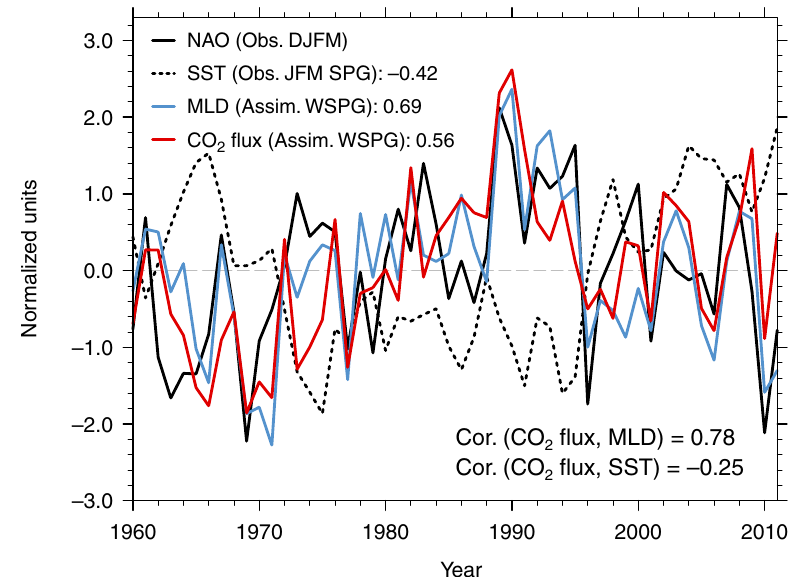
Figure 2 | Normalized time series of CO 2 flux and related physical variables. The observed (Obs.) DJFM NAO 21 , observed JFM SST 22 in SPG region, western SPG (WSPG) MLD and CO 2 flux calculated with the assimilation run are shown with black solid line, black dashed line, blue solid line and red solid line, respectively. The location of SPG and WSPG refers to green box in Fig. 1a,b, respectively. The correlation (Cor.) coefficients between time series and NAO (CO 2 flux) are shown on the top (bottom) of the figure. The normalized time series are calculated by dividing individual variable anomalies with their respective standard SST 22 and mixed layer depth (MLD) in the assimilation run (Fig. 2). The western SPG MLD and CO 2 flux from our model results are highly correlated (with a correlation coefficient of 0.78), and both are highly correlated (with correlation coefficients of 0.69 and 0.56, respectively) with the observed December– January–February–March (DJFM) NAO index. The correlations are significantly different from zero with P values below 0.01.